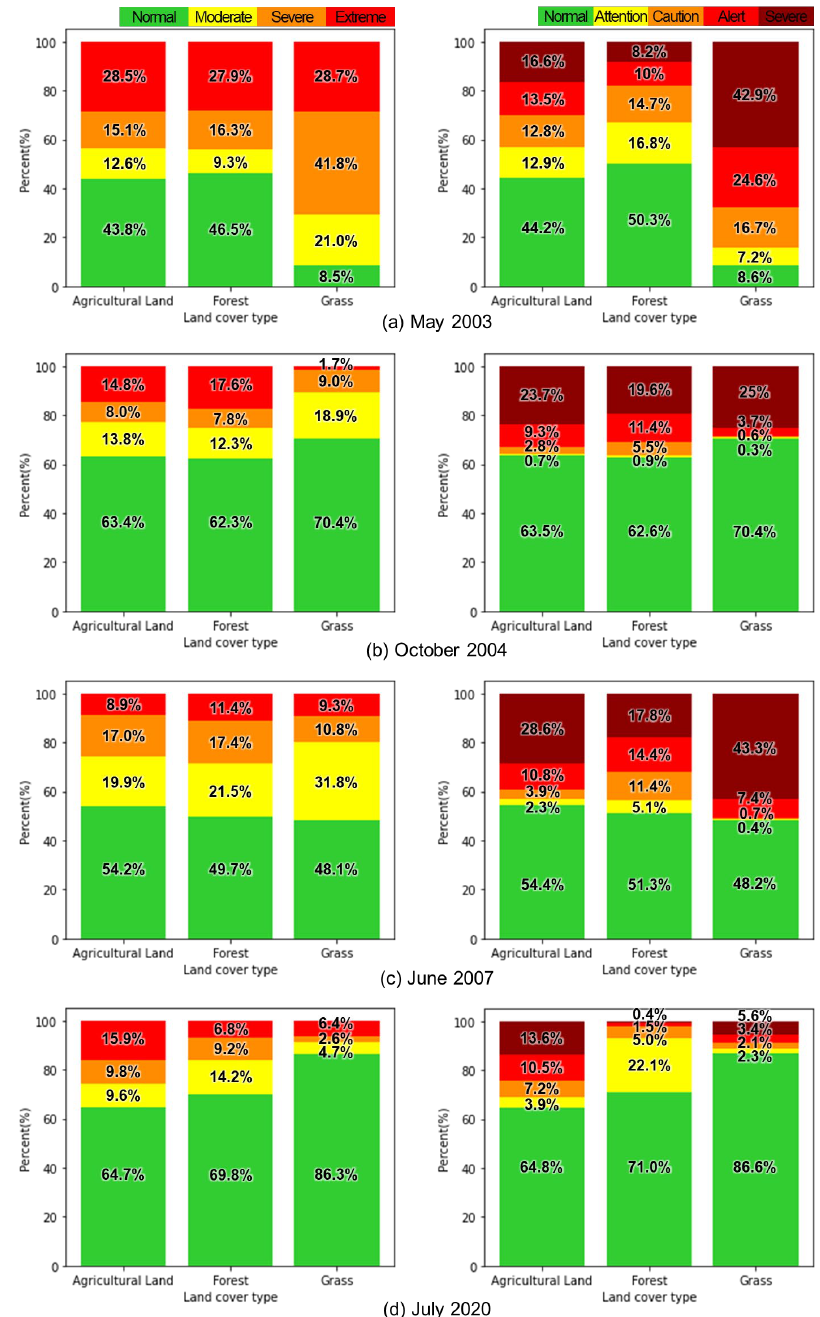
Figure 10. Percentage of meteorological drought ( Left ) and ecological drought ( Right ) levels experienced by each land cover type for ( a ) May 2003, ( b ) October 2004, ( c ) June 2007 and ( d ) July 2020. Meanwhile, the effects of meteorological drought on vegetation may differ depend- ing on anthropogenic activities. For example, if a meteorological drought occurs in the